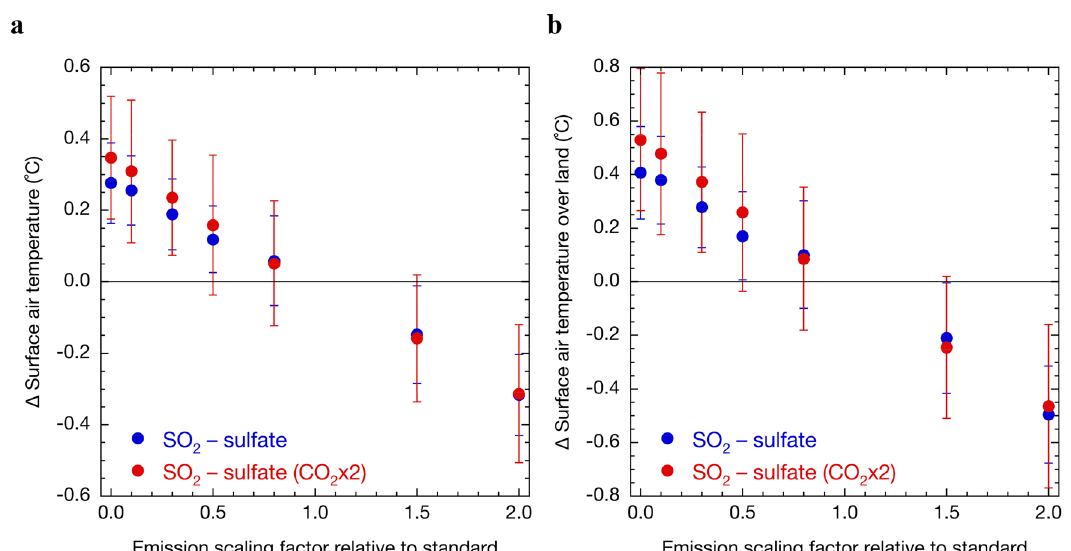
Figure 3. Sensitivity of surface air temperature to changes in SO 2 emissions. The global average ( a ) and land average ( b ) changes of the annual mean surface air temperature under present (blue) and doubled (red) CO 2 concentrations with the SO 2 emission perturbations due to fuel sources relative to present emissions simulated by the coupled atmosphere–ocean MIROC-SPRINTARS. Error bars represent the standard deviation of the global and annual means obtained from the analyzed 50-year